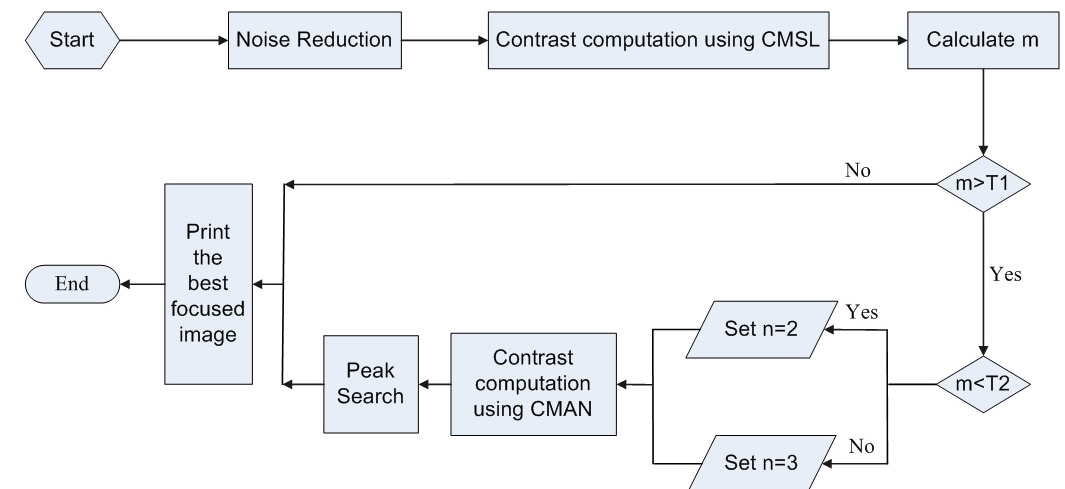
Figure 4. Proposed passive AF algorithm using